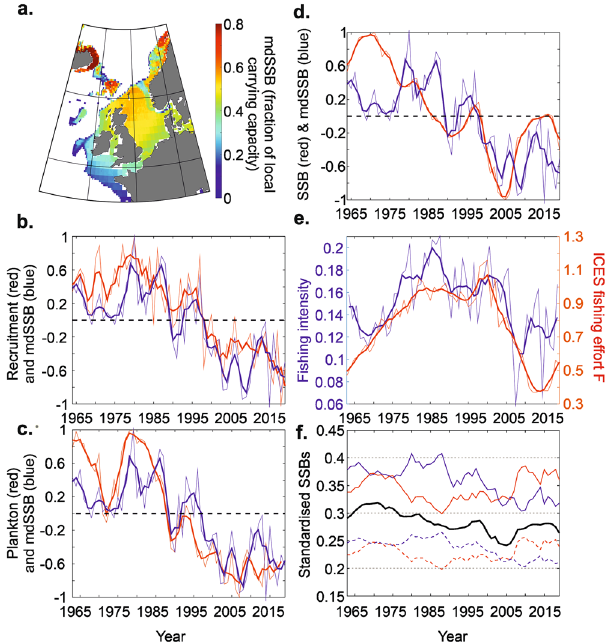
Fig. 1 Maximum standardised spawning stock biomass mdSSB (K) and fi shing intensity ( α ) modelled by FishClim in relation to observed changes in a plankton index of larval cod survival, recruitment at age 1, Spawning Stock Biomass (SSB) and ICES fi shing effort F in the North Sea. a Spatial patterns of average mdSSB (i.e. without fi shing) for the period 1997 – 2019 (i.e. measured chlorophyll data). b Long-term changes in cod recruitment at age 1 with a lag of 1 year (red) in relation to long-term changes in mdSSB (blue); c Long-term changes in mdSSB (blue) in relation to long-term changes in a plankton index of larval cod survival (red) updated from Beaugrand and colleagues 33 . Long-term changes in mdSSB (1963-2019) were based on modelled daily chlorophyll data. d Long-term changes in cod ICES SSB with a lag of 1 year (red) in relation to long-term changes in mdSSB (blue). e Long-term changes in estimated fi shing intensity α (blue) in relation to long-term changes in ICES fi shing effort F (red). All time series in ( b – d ) were standardised between − 1 and 1 and thick lines in ( b – e ) were the original time series smoothed by means of a fi rst-order simple moving average. f Modelled standardised SSB based on long-term changes in the environment and assessed fi shing intensity (thick black line) with (i) modelled standardised SSB based on a constant environment fi xed to the minimum (dashed red curve) or optimal (full red curve) value observed for 1963 – 2019 and long-term changes in fi shing intensity α and (ii) modelled standardised SSB based on a constant fi shing intensity fi xed to the mimimum (full blue curve) or the maximum value (dashed blue curve) observed for 1963 – 2019 and long-term climate- induced environmental